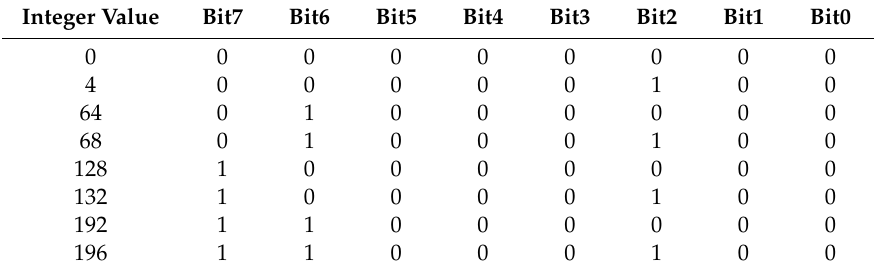
Table 3. Integer values selected from the Quality Assessment (QA) layer in order to derive the no-Land class associated with the binary mask.